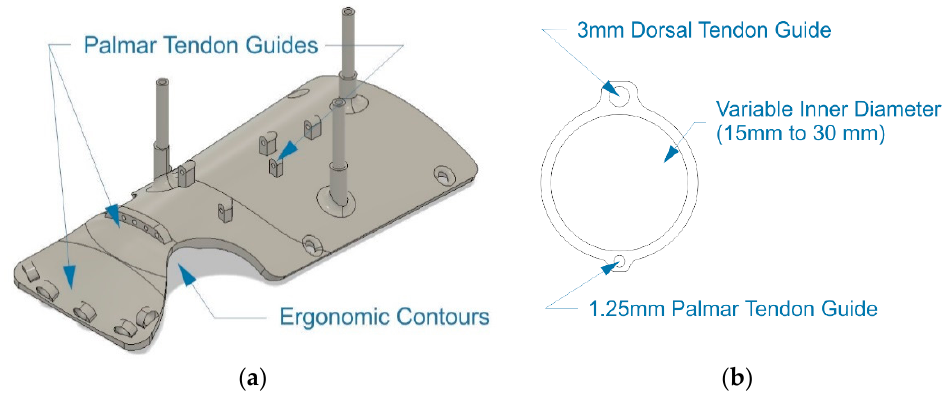
Figure 4. ( a ) Wrist support structure detailing palmar tendon guides and ergonomic contours. ( b ) 2D profile detailing tendon attachment points for the ring system.